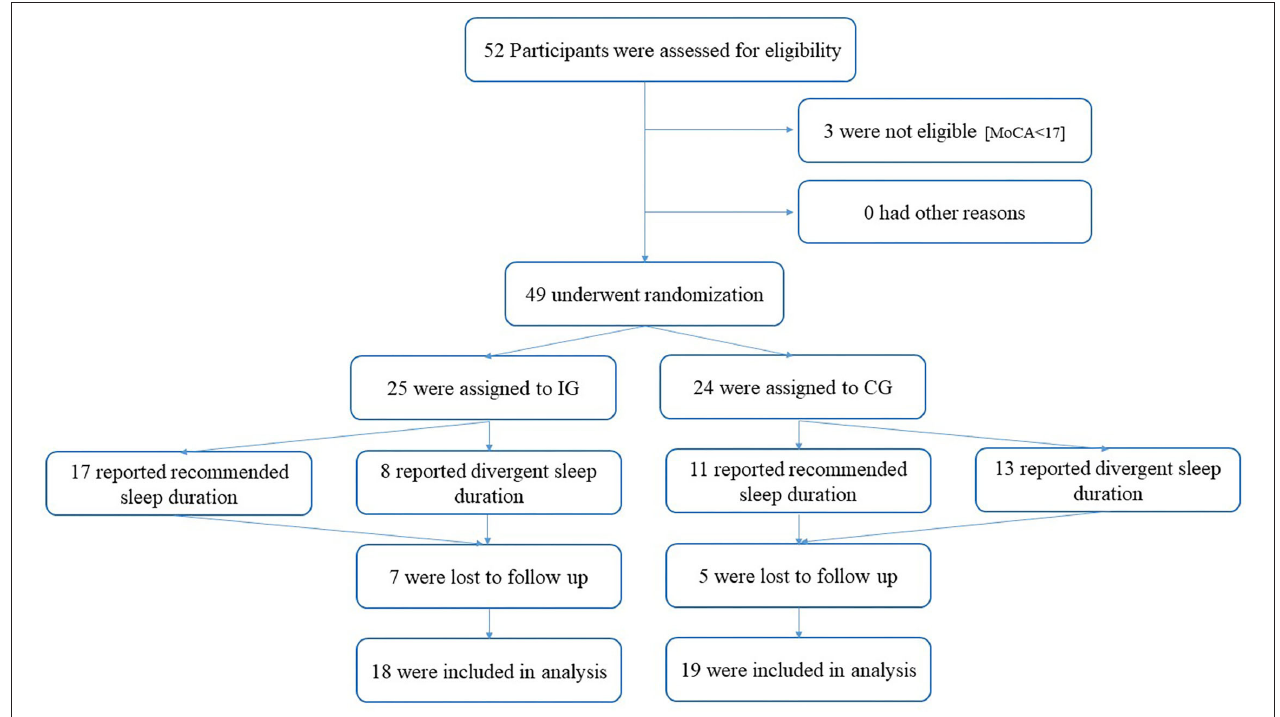
FIGURE 1 | Participant flow. IG, Intervention Group; CG, Control Group; MoCA, Montreal Cognitive Assessment).